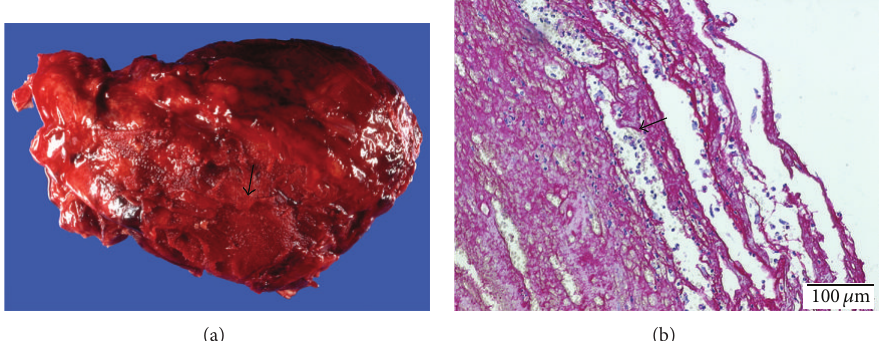
Figure 2: (a) Anterior view of the heart ex vivo : areas covered with fibrin glue resulting in a partial fibrinous pericarditis of the anterior wall (see arrow). (b) Factor VIII staining of fibrin clot: fibrin clot shows disseminated infiltration by lymphocytes and macrophages as commonly found in fibrinous